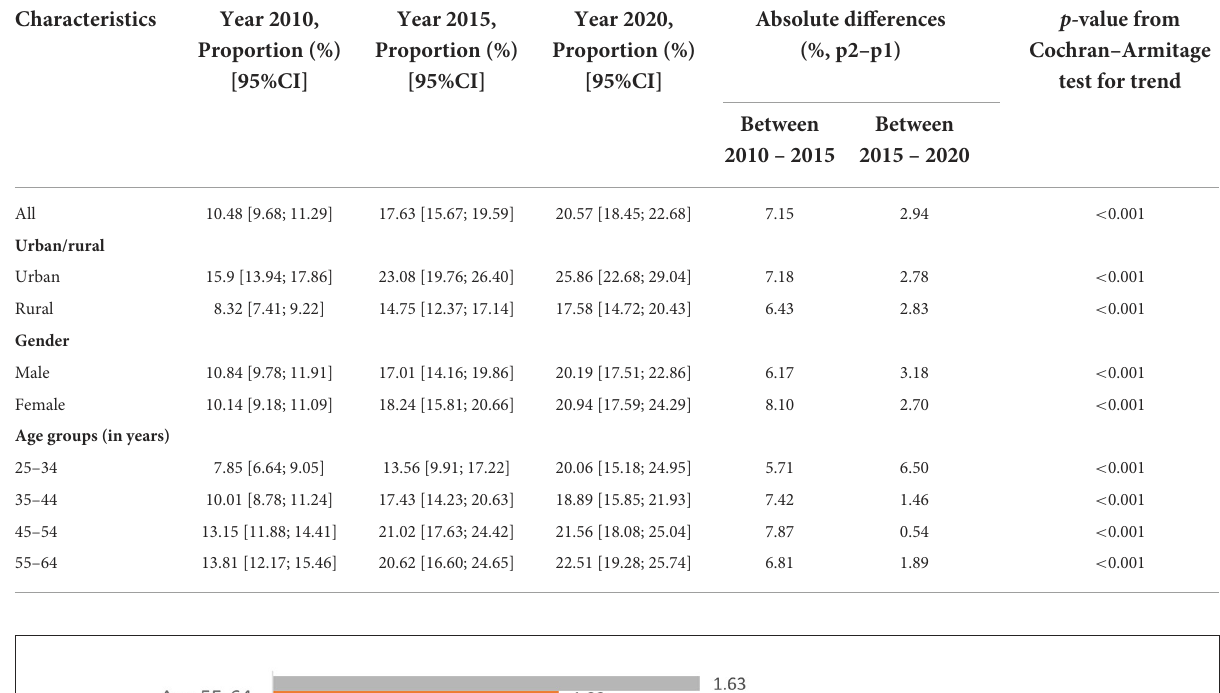
TABLE 2 Changes in the prevalence of overweight/obesity over time.